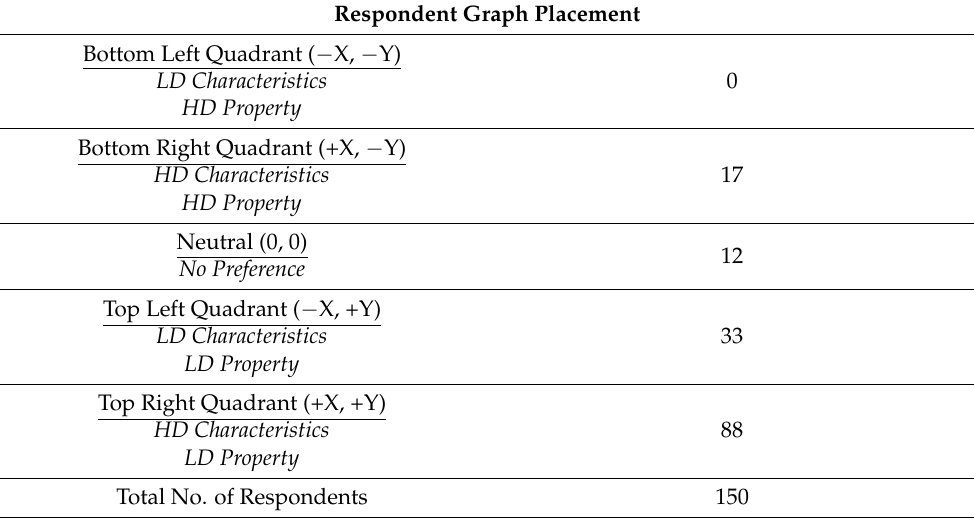
Table 5. Sydney Residents’ Preferences—Graph